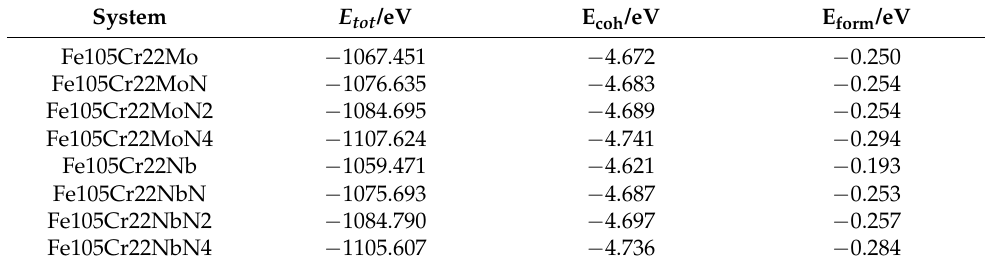
Table 3. Total, cohesive and formation energies of systems with different substitutional solid